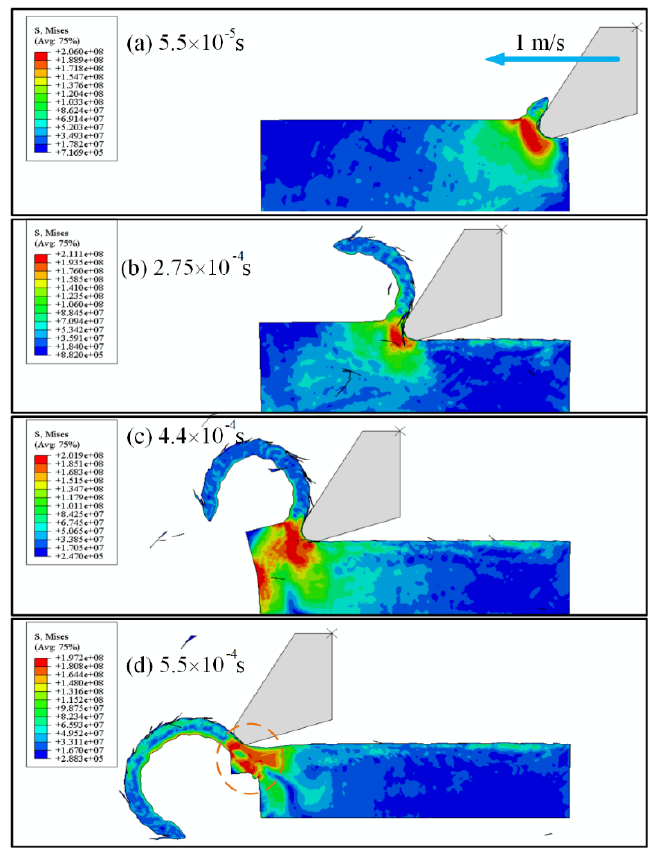
Figure 18. Chip formation during cutting the deposited filament.